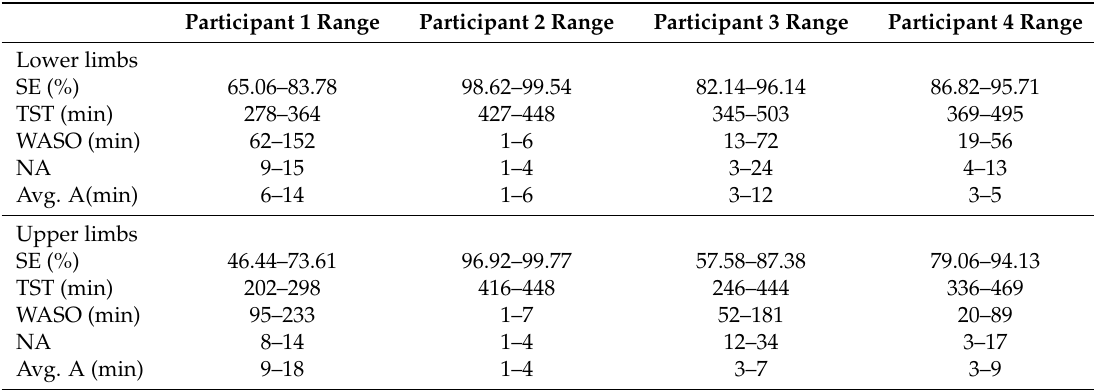
Table 3. Within-participant variance of actigraph